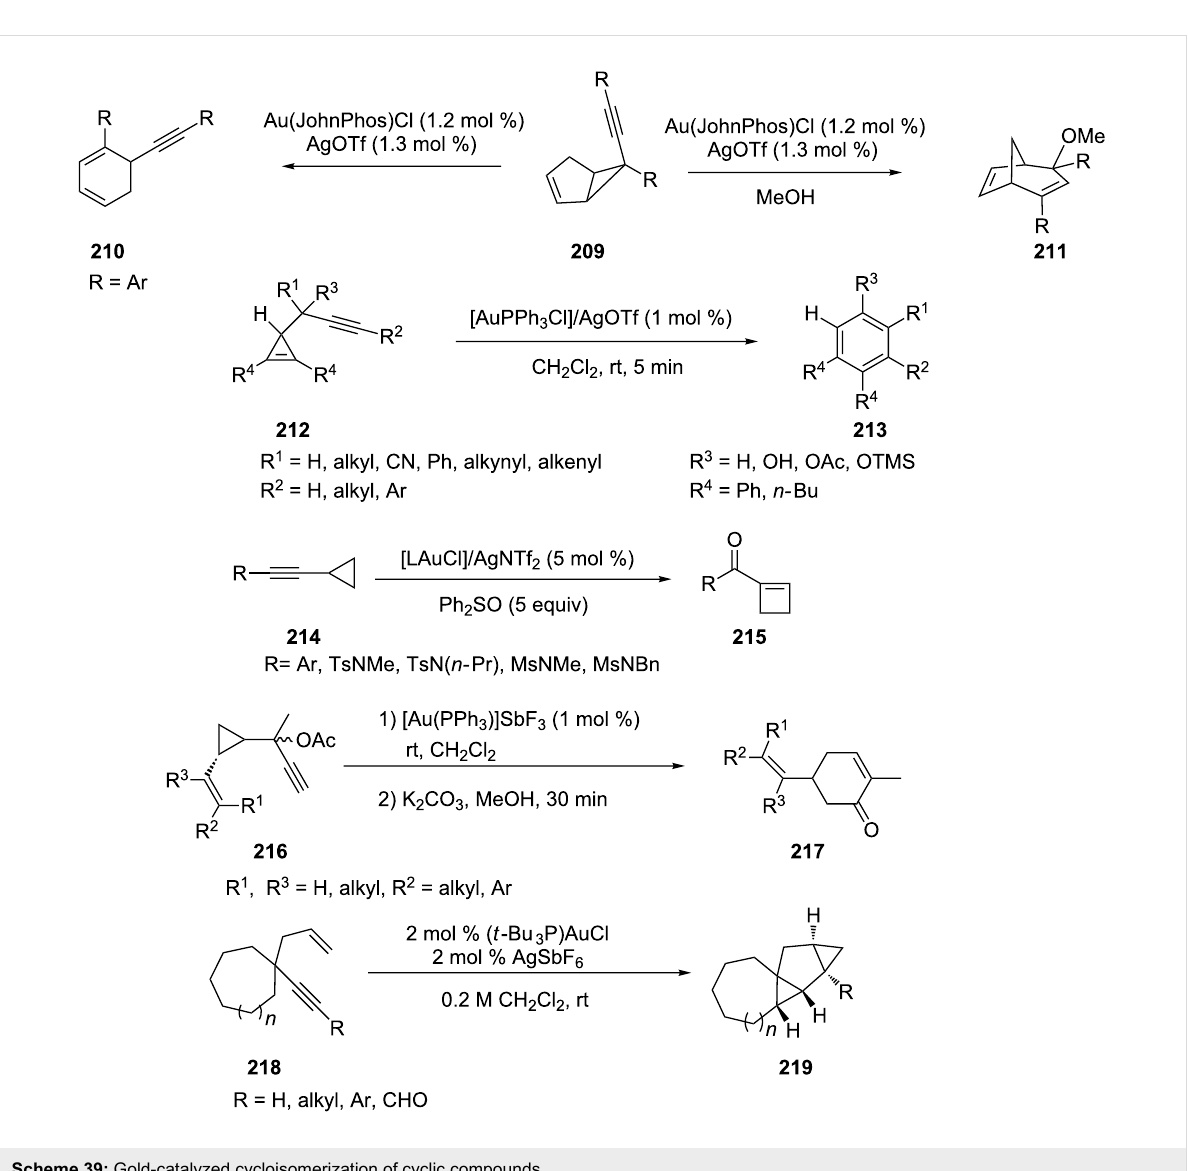
Scheme 39: Gold-catalyzed cycloisomerization of cyclic